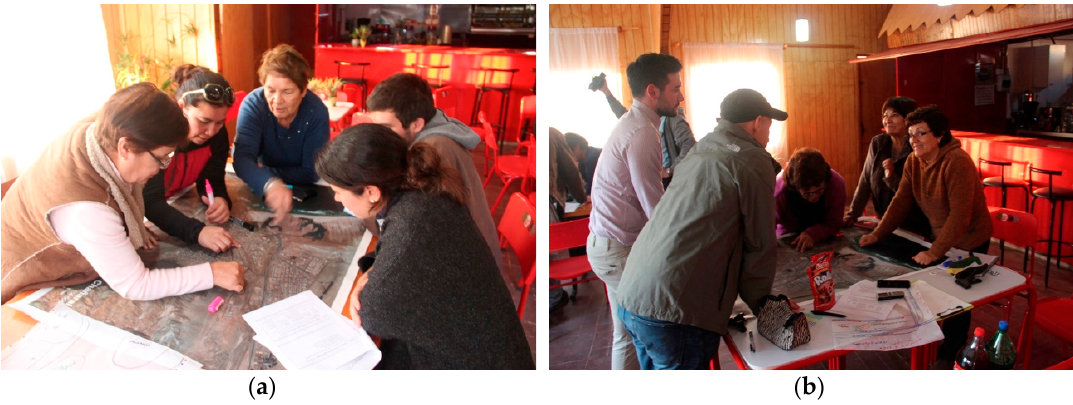
Figure 6. Community mapping workshop. Exercise 2–Satellite Map: ( a ) Group 1, ( b ) Group 2.